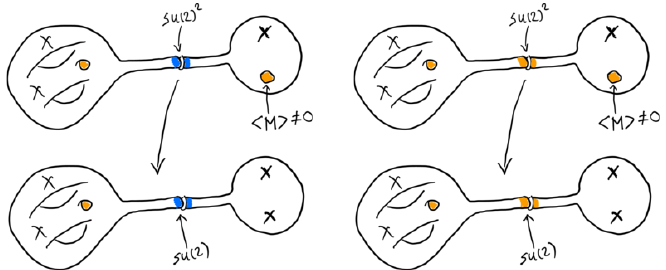
Figure 5 . We can derive a description of a theory in a duality frame where two minimal punctures sit on the same pair of pants. First we start with a theory with one minimal puncture switched for a maximal one, and then give a vacuum expectation value to a mesonic operator corresponding to the maximal puncture. The choice of the pair of pants with two maximal and one minimal puncture gives di(cid:11)erent dual descriptions of the same model. On the left we take the trinion to be the free one and on the right an interacting trinion of (cid:12)gure 6.